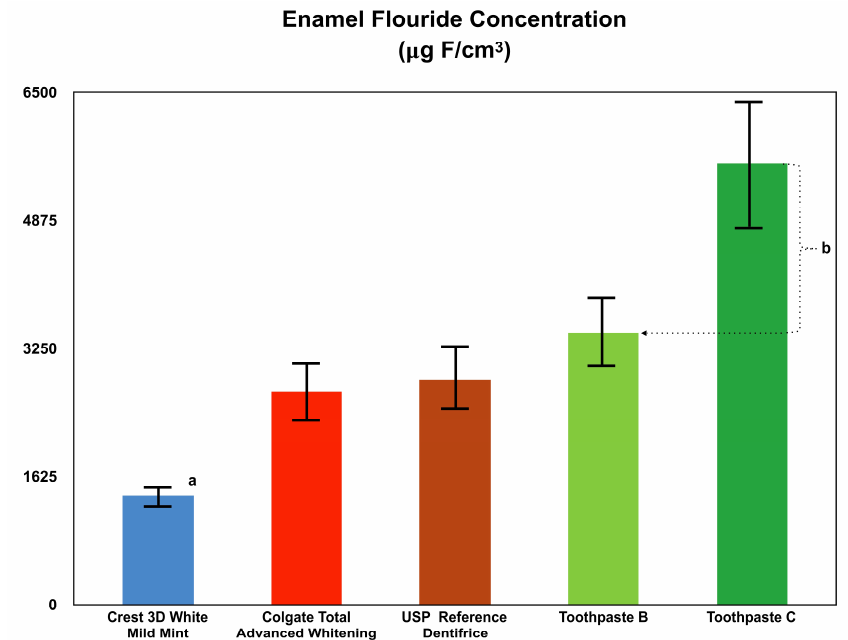
Figure 1. Comparison of enamel fluoride uptake between Crest 3D White Mild Mint, Colgate Total Advanced Whitening, United States Pharmacopoeia (USP) Reference Dentifrice, Toothpaste B, and Toothpaste C. Eighteen replicates (n = 18) of each toothpaste were run and individual mean differences were analyzed by Student–Newman–Keuls analysis. a Brackets represent two standard deviations, mean ± one standard deviation. b Significant difference, p < 0.001.